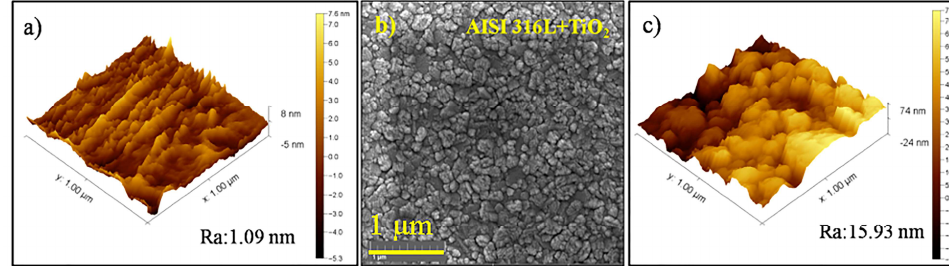
5 of 13 Figure 1. ( a ) AFM image of the AISI 304 surface before film deposition. ( b ) FEG-SEM image of the TiO 2 thin film deposited on AISI 304 (magnification of 80 kx). ( c ) AFM image of the TiO 2 film surface.